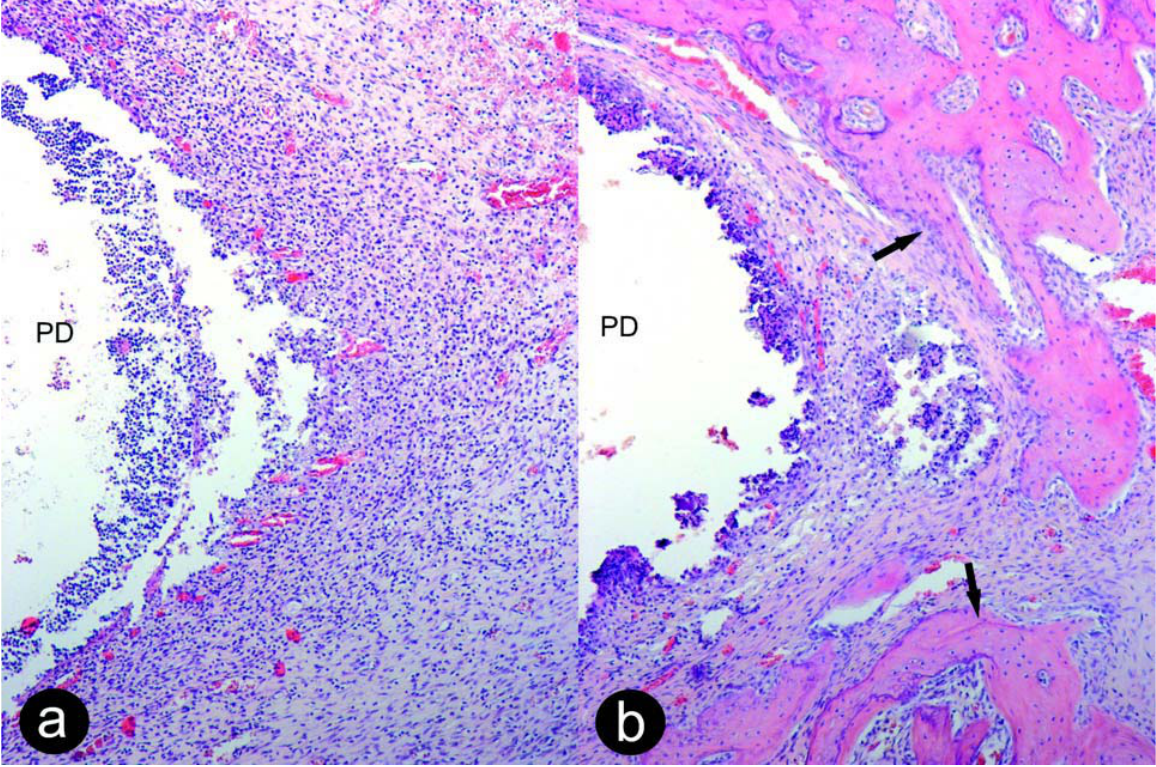
FIGURE 4- This image shows the behavior of Group III at 7 days (a) and 28 days (b) close to the periodontal dressing (PD). The arrows indicate bone tissue formation. HE, original magnification